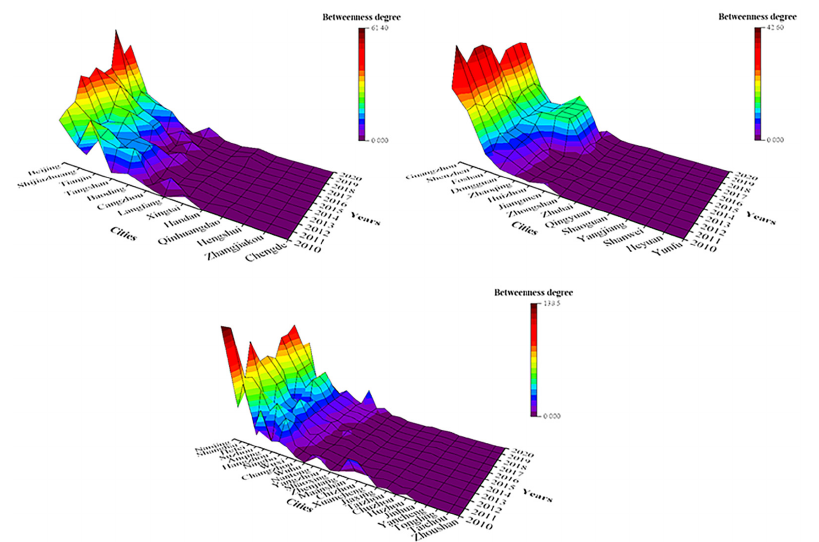
Figure 9. Cities’ betweenness degree of the housing prices’ association network in the BTHUR ( upper left ), the PRDUR ( upper right ), and the YRDUR ( bottom ) from 2010 to 2020.